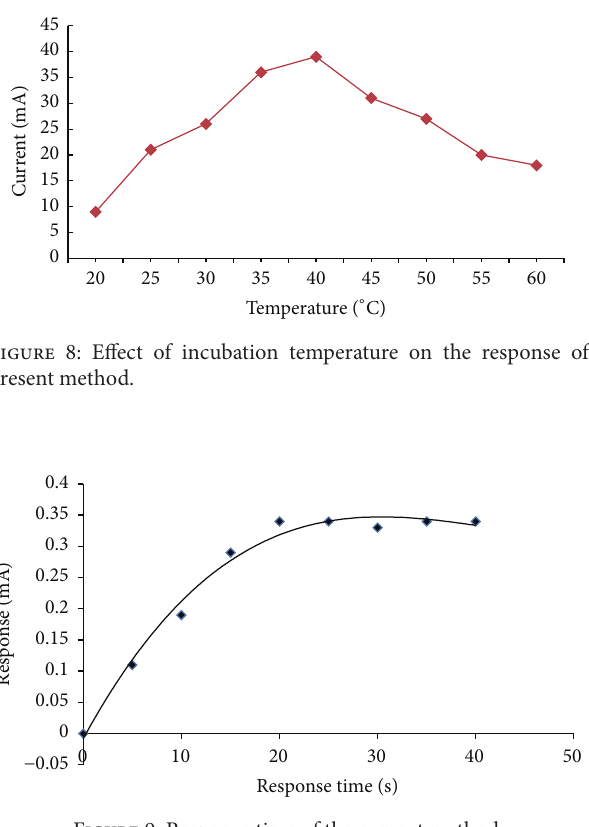
Figure 9: Response time of the current method.